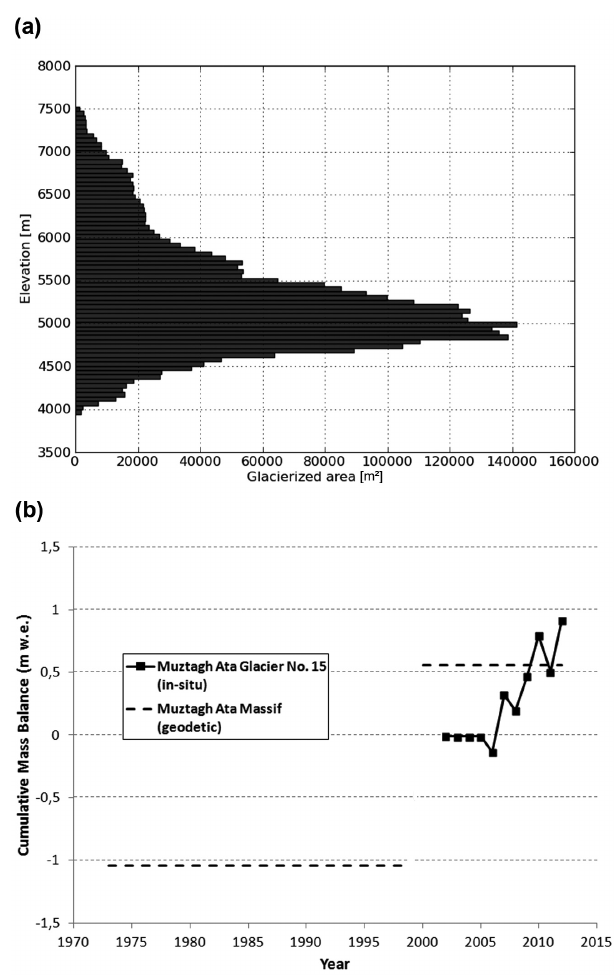
Figure 3. (a) Hypsometry of the glacierized area at Muztagh Ata, (b) cumulative glaciological mass balance of Muztagh Ata Glacier No. 15 (G075058E38248N) vs. cumulative geodetic mass balance of the entire Muztagh Ata Massif.